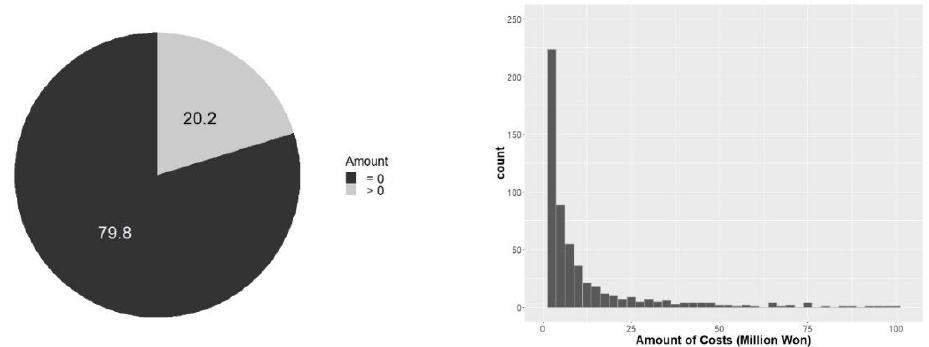
Figure 4. Distribution of Amount of Costs (the measurements above 100 million won (0.6%) are not displayed in the histogram).